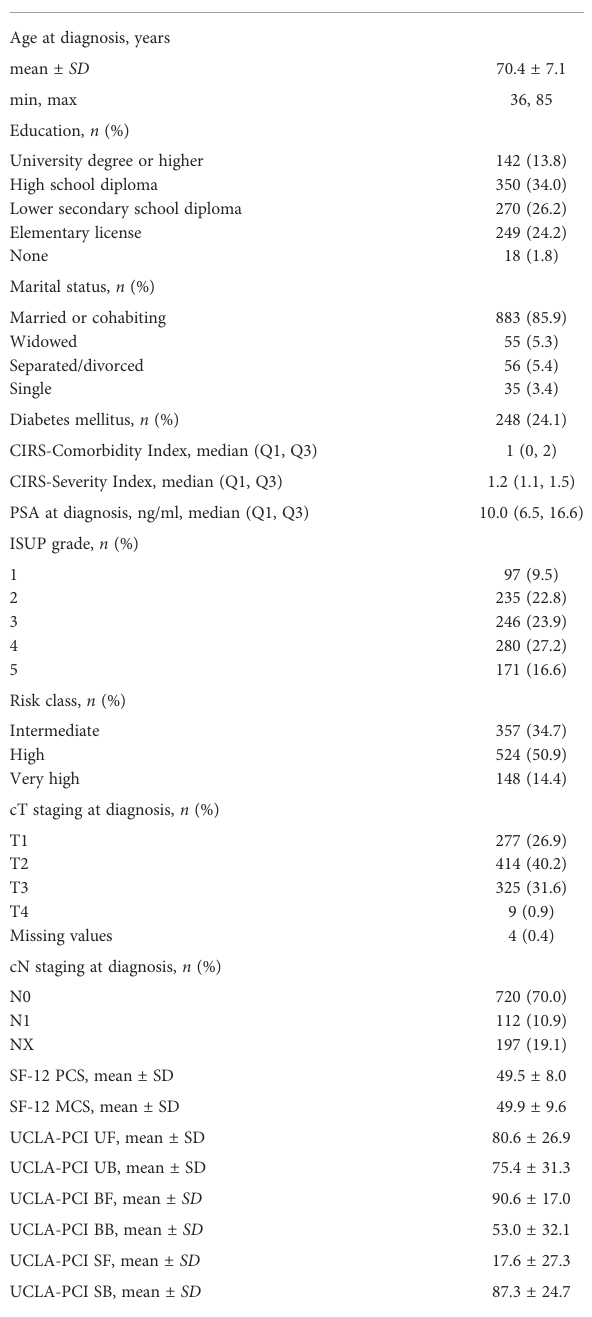
TABLE 1 Characteristics of the study participants at the